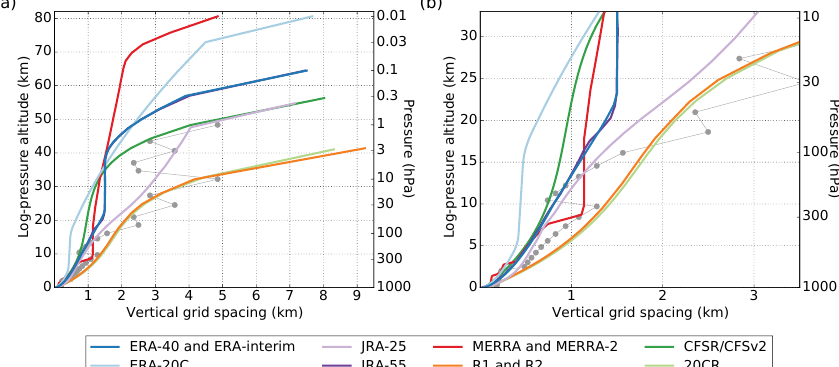
Figure 3. Approximate vertical resolutions of the reanalysis forecast models for (a) the full vertical range of the reanalyses and (b) the surface to 33km ( ∼ 10hPa). Altitude and vertical grid spacing are estimated using log-pressure altitudes ( z ∗ = H ln [ p 0 /p ] ), where the surface pressure p 0 is set to 1000hPa and the scale height H is set to 7km. The grid spacing indicating the separation of two levels is plotted at the altitude of the upper of the two levels, so that the highest altitude shown in (a) indicates the lid location. Some reanalyses use identical vertical resolutions; these systems are listed together in the legend. Other reanalyses have very similar vertical resolutions when compared with other systems, including JRA-55 (similar but not identical to ERA-40 and ERA-Interim) and 20CR (similar but not identical to R1 and R2). Approximate vertical spacing associated with the isobaric levels on which ERA-40 and ERA-Interim reanalysis products are provided (grey discs) is shown in both panels for